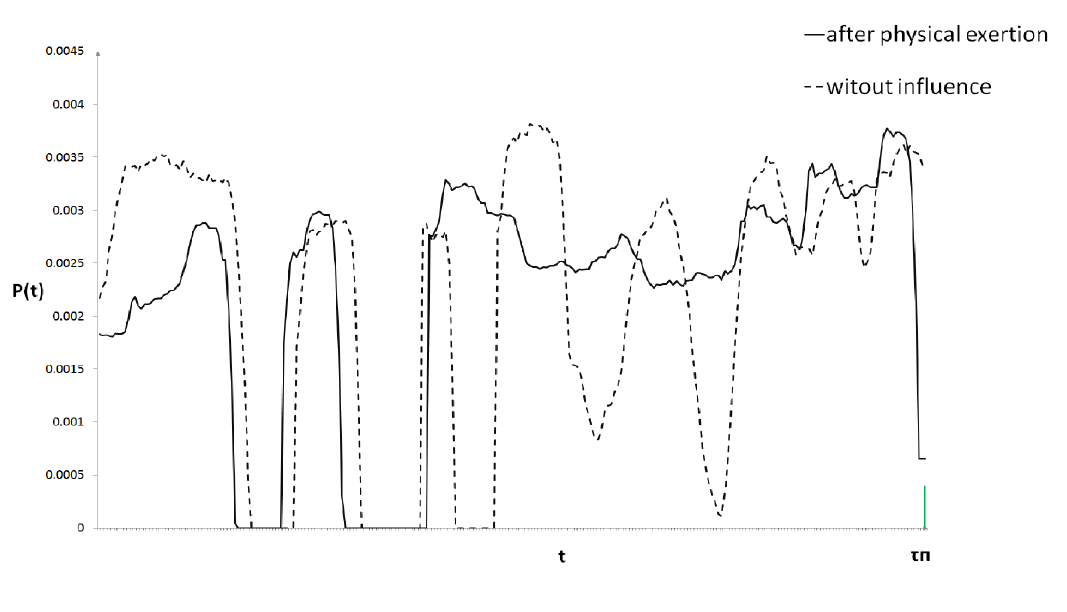
Figure 4. The pen pressure function after the normalization procedure when an employee reproduces a signature being in different psychophysiological